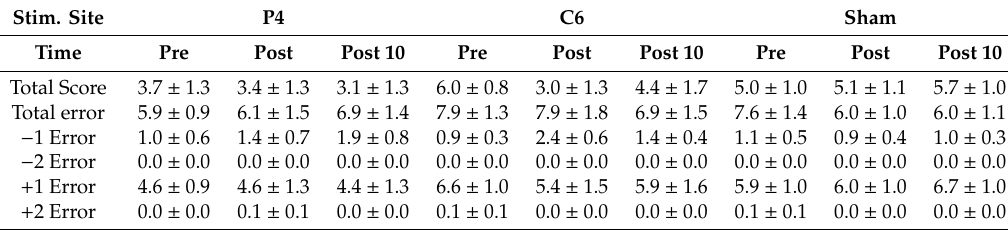
Table 3. The total score and the number of errors in the line length judgement task for the right-biased group (mean ± SEM). n = 7. Stim. Site P4